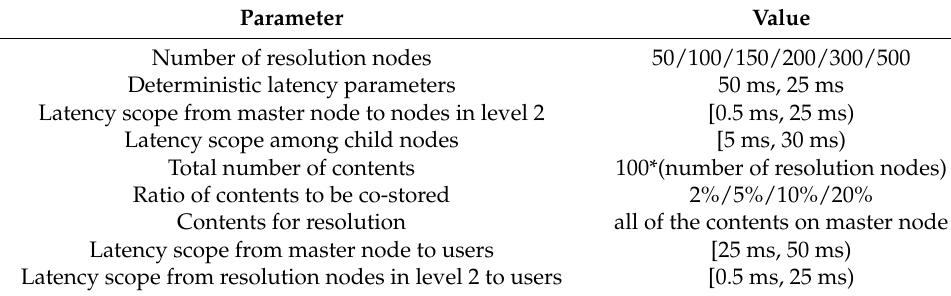
Table 1. Evaluation